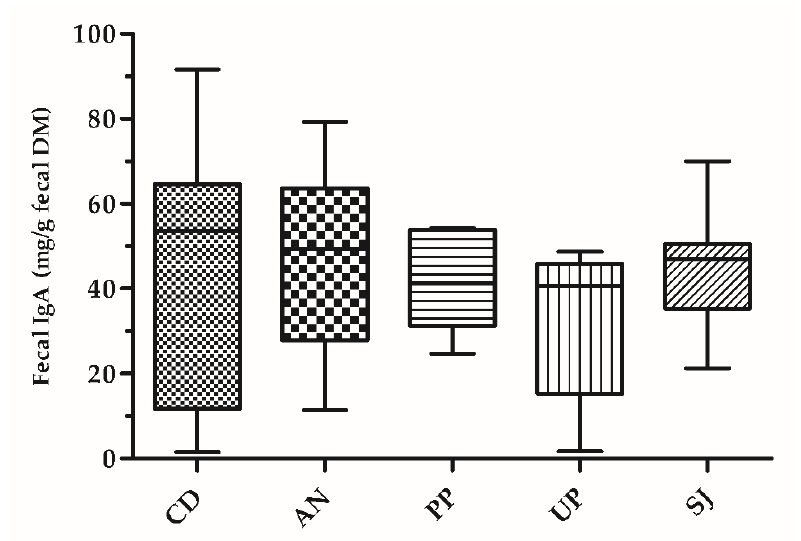
Figure 1. Fecal IgA concentrations (mg/g fecal DM) in dogs fed with a control diet supplemented or not with different intact seaweeds. Values are the means of 10 dogs per treatment. CD, control diet; AN, control diet supplemented with Ascophyllum nodosum ; PP, control diet supplemented with Palmaria palmata ; UP, control diet supplemented with Undaria pinnatifida ; SJ, control diet supplemented with Saccharina japonica .